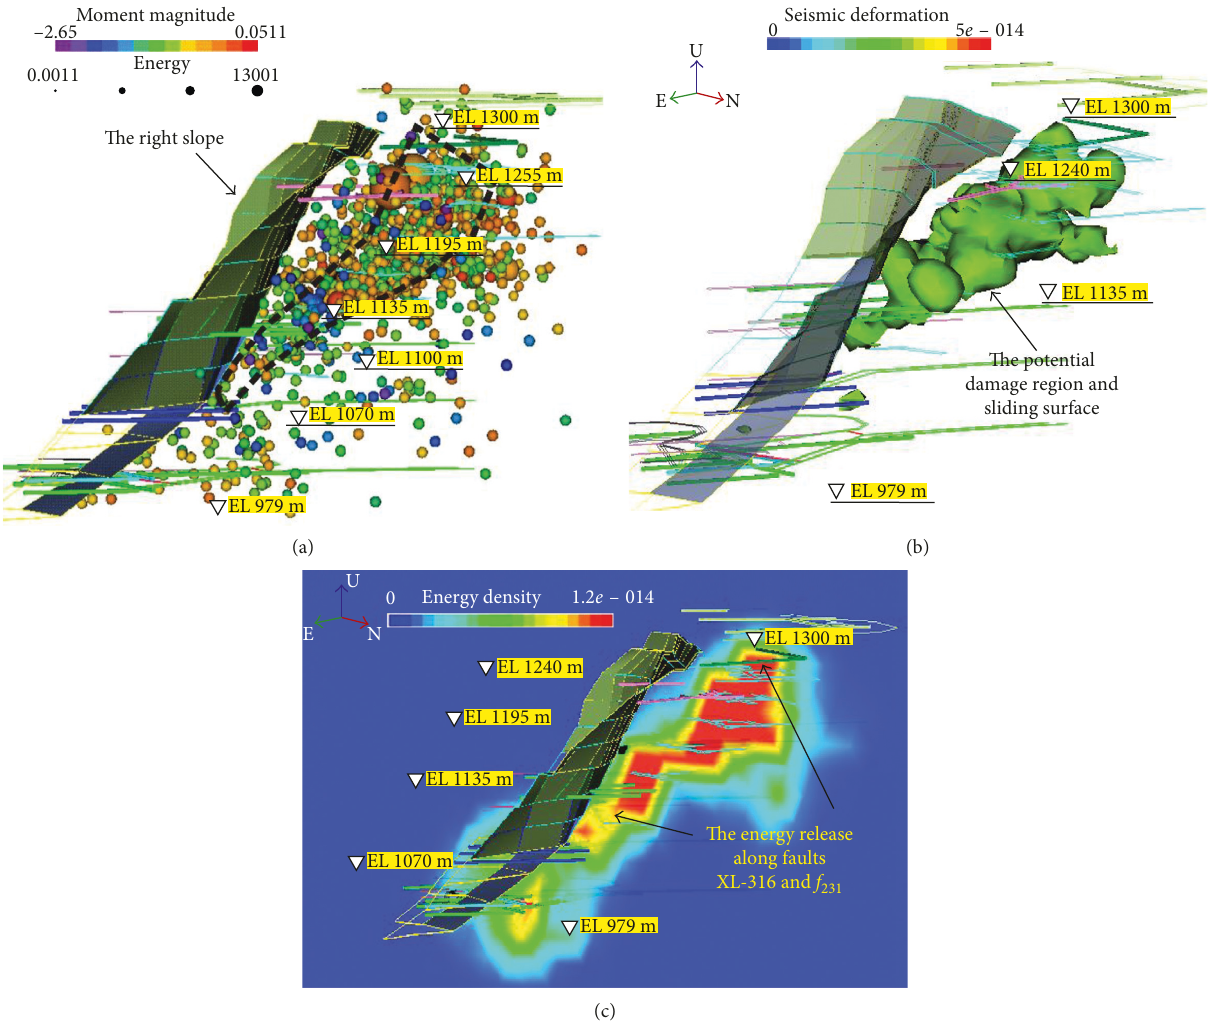
Figure 9: (a) Cross-sectional view of the spatial distribution of MS events recorded between May 2010 and May 2012 during slope excavation, (b) north-east plane of the seismic deformation, and (c) north-east plane of the energy release density contours. Different colours represent different quantities of energy dissipation density per unit